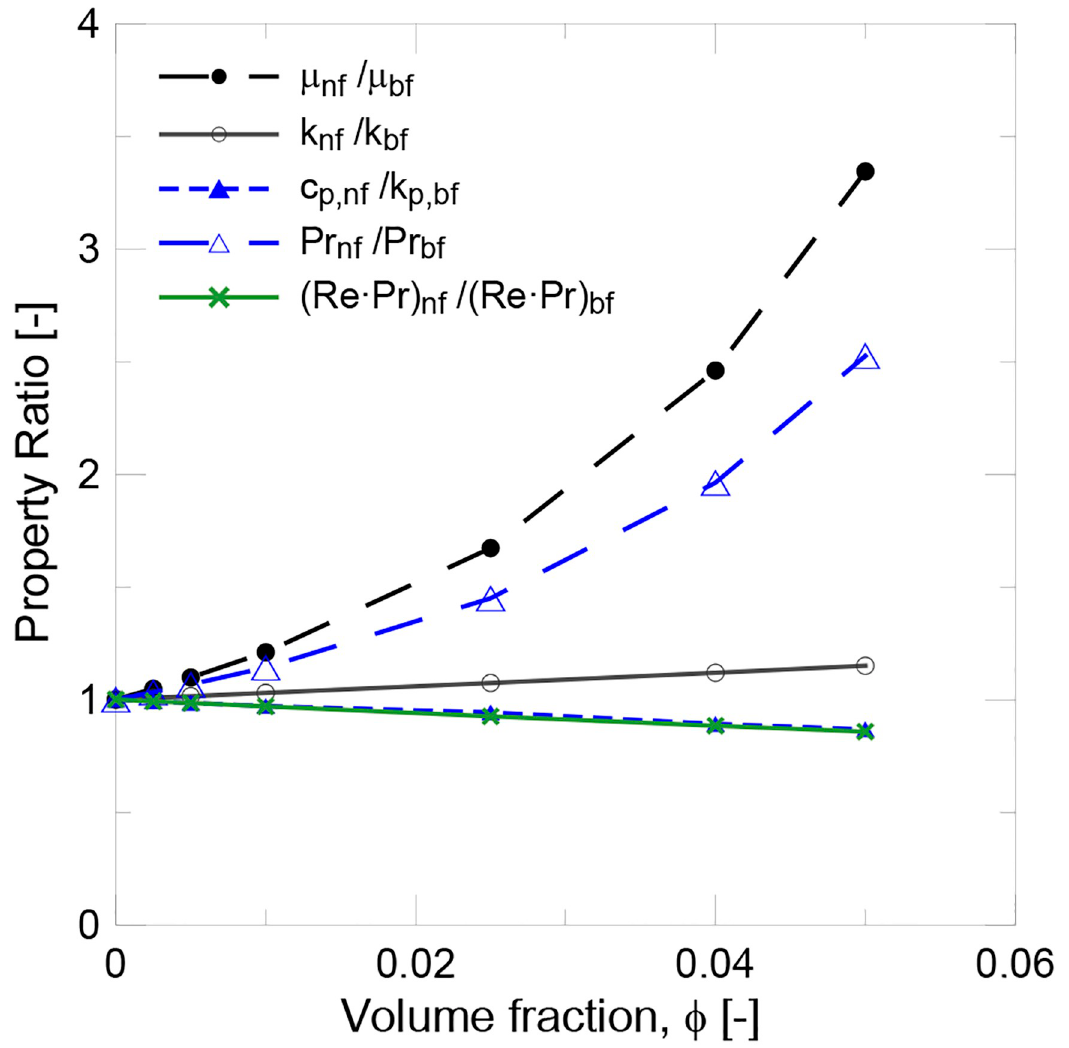
Fig 3. Evolution of thermal conductivity, specific heat, viscosity, and the Pr and (Re � Pr) ratios with the volume fraction.